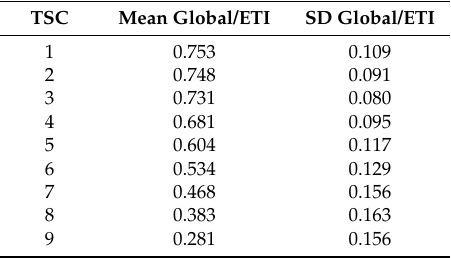
Table 2. Ratio of global to extra-terrestrial irradiation by TSC